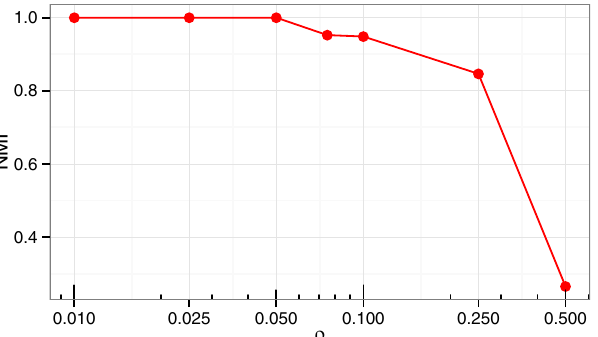
Figure 3. The figure shows the NMI values obtained by running the proposed method on the perturbed GN network instances with different values of edge rewiring probability ( ρ